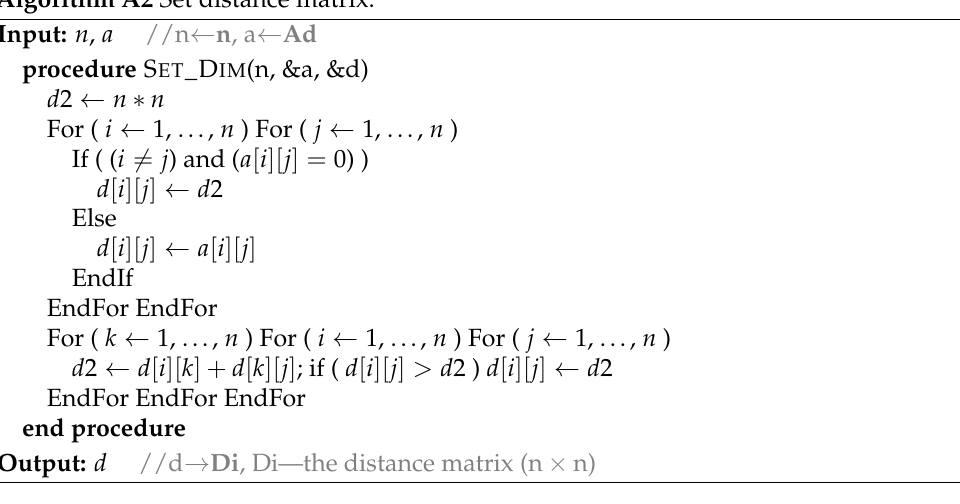
Algorithm A3 Set graph diameter.